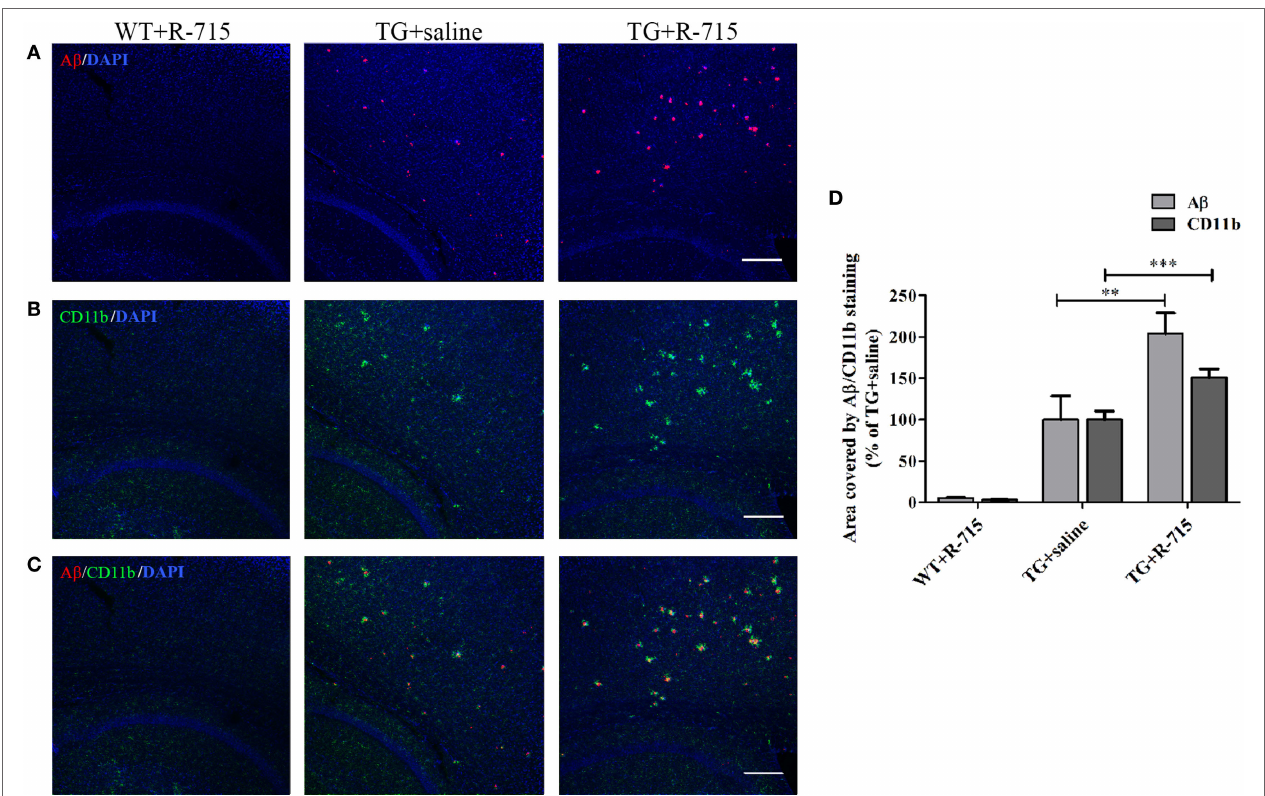
FigUre 5 | effects of intranasal delivery of the bradykinin B 1 receptor antagonist on amyloid burden and the accumulation of microglial cells in the cortex of 5X familial aD (5XFaD) mice . Two-month-old mice were treated with R-715 or the vehicle for 3½ weeks. After cardiac perfusion, their brains were cut into sections, stained for A β ( red ) (a) and CD11b (microglial accumulation) ( green ) (B) using appropriate antibodies and counter-stained with DAPI ( blue ). Representative confocal images of cortical sections from wild-type (WT) or 5XFAD mice (TG) are shown. (c) Merged images of A β and CD11b staining. The dose of intranasally administered R-715 was 1 mg/kg/day. Each group included 4–8 mice ( n = 14–23 per experiment). The stained areas were quantified. The mean ± SEM of percentage of the stained areas is shown in the graphs, n ≥ 3 determinants (D) . For statistical comparisons, a one-way analysis of variance and Tukey–Kramer Multiple Comparison Test were conducted. *** P < 0.001 versus TG + saline; ** P < 0.01 versus TG + saline. The scale bar is 200